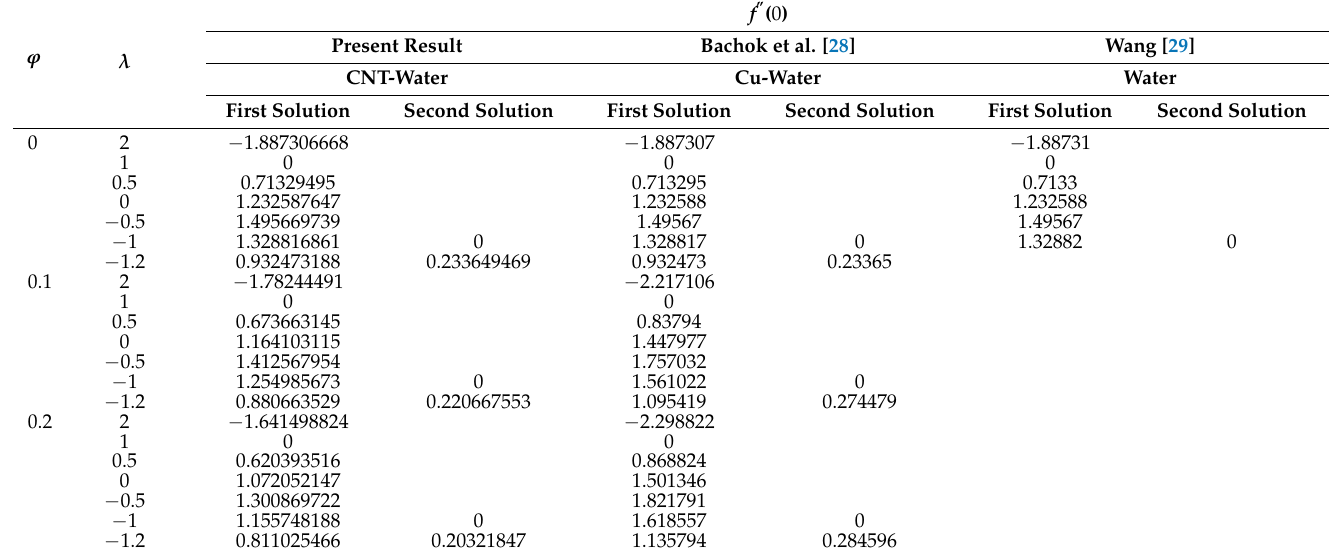
Table 3. Comparison several of numerical result f (cid:48)(cid:48) ( 0 ) when stretching/shrinking case and M = ε = 0 with the change of ϕ and λ in